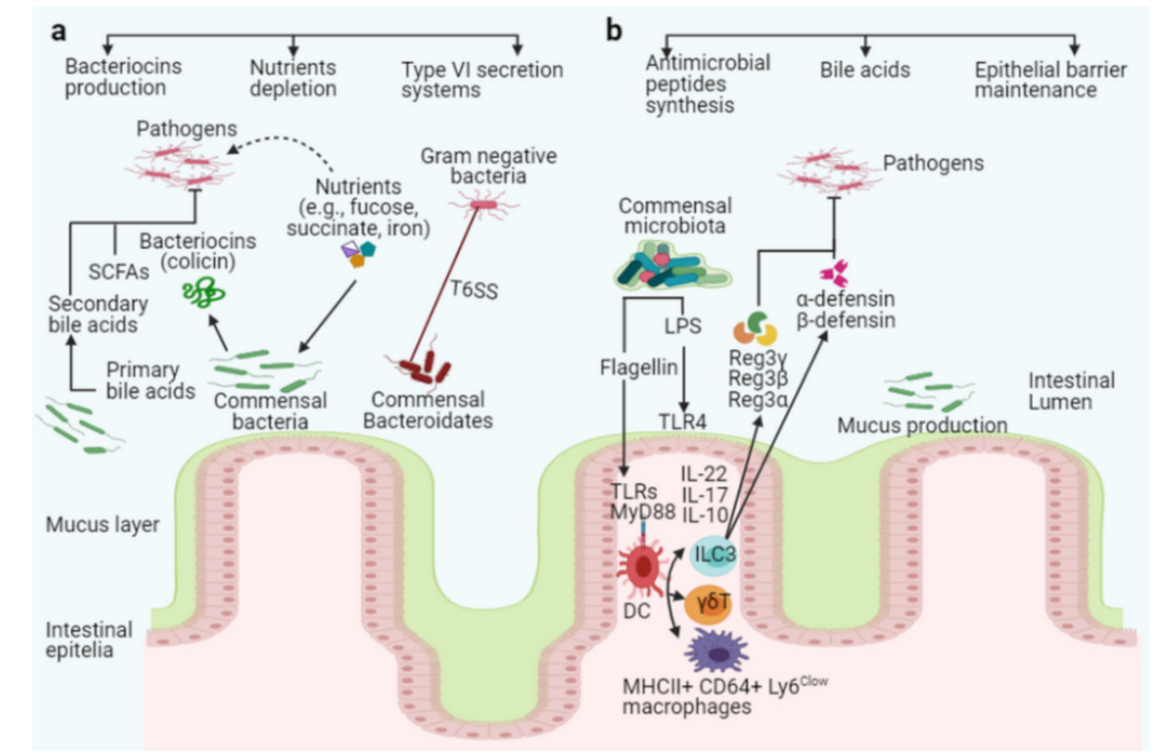
Figure 2. The intestinal microbiota acts as a barrier against enteric pathogens via direct and indirect colonization resistance mechanisms. Direct colonization resistance mechanisms ( a ): Several commensal Bacteroidetes prevent pathogens from colonizing the intestinal mucosa, and the commensal E. coli Nissle strain consumes nutrients, limiting nutrients availability to specific pathogens (pink color with flagella). The probiotic E. coli Nissle strain can also absorb iron, limiting its availability to the pathogen S. Typhimurium . Commensal bacteria secrete antimicrobial peptides, such as bacteriocins (colicin), SCFAs, and T6SS, to target and kill invading pathogens. Together with antimicrobial peptides, commensal bacteria produce enzymes that convert conjugated primary bile acids to secondary bile acids (toxic to invading pathogens). Indirect colonization resistance mechanisms ( b ): Surface antigens such as flagellin or LPS from commensals bacteria stimulate host innate immunity via TLRs and MyD88 on epithelial or dendritic cells (DCs). ILC3, γδ T, and Th17 cells can be activated to produce interleukin IL-10, IL-17, and IL-22, which promotes secretion of the antimicrobial peptides Reg3 γ , Reg3 β , Reg3 α , α -defensin, and β -defensin from epithelial cells to inhibit pathogen colonization in the intestines (pink color with